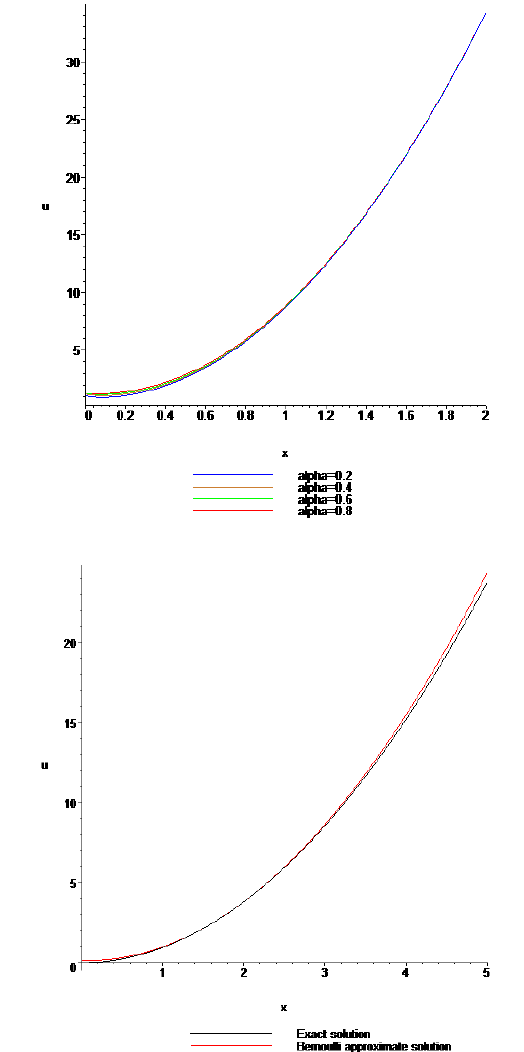
Figure 4. First one is the comparison of  values for the obtained solution; the second one is the comparison of exact solution with the analytical solution obtained via Bernoulli approximation